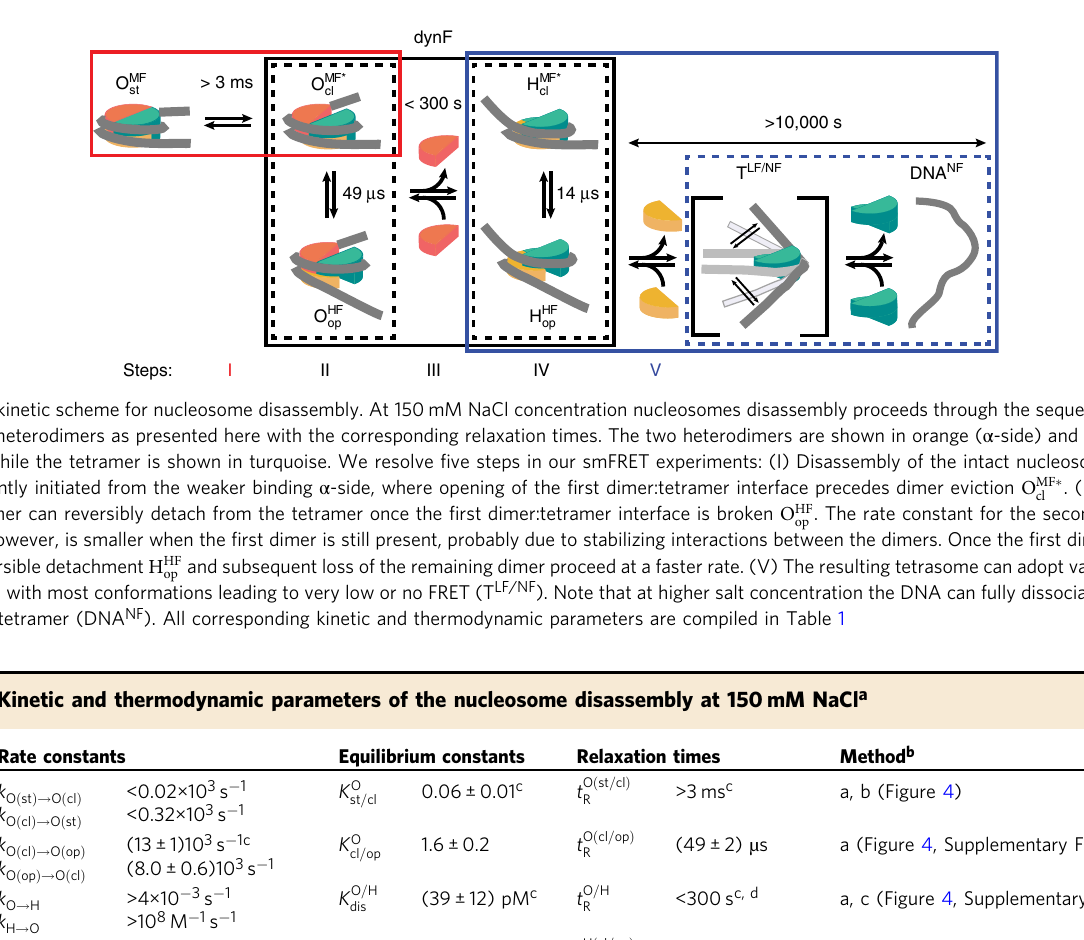
a The reaction scheme and the nucleosome species are displayed in Fig. 8 with the following characterization: (O) octasome, (H) hexasome, (T) tetrasome; (st) static closed, (cl) dynamic closed, (op) dynamic